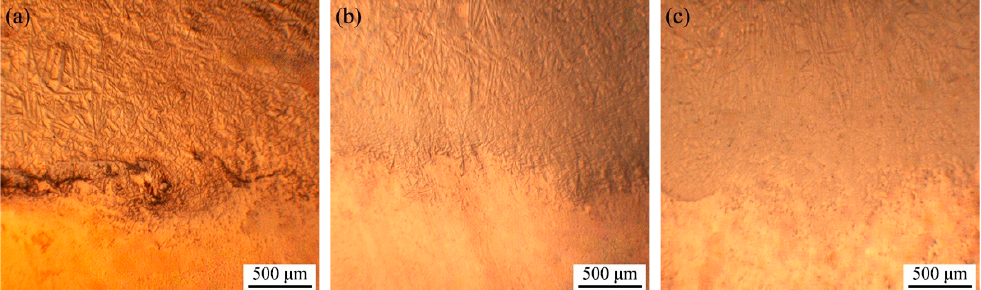
Figure 4. Interface bonding of composite coating at different energy densities. ( a ) 53.33 kJ/cm 2 ; ( b ) 60.00 kJ/cm 2 ; ( c ) 66.67 kJ/cm 2